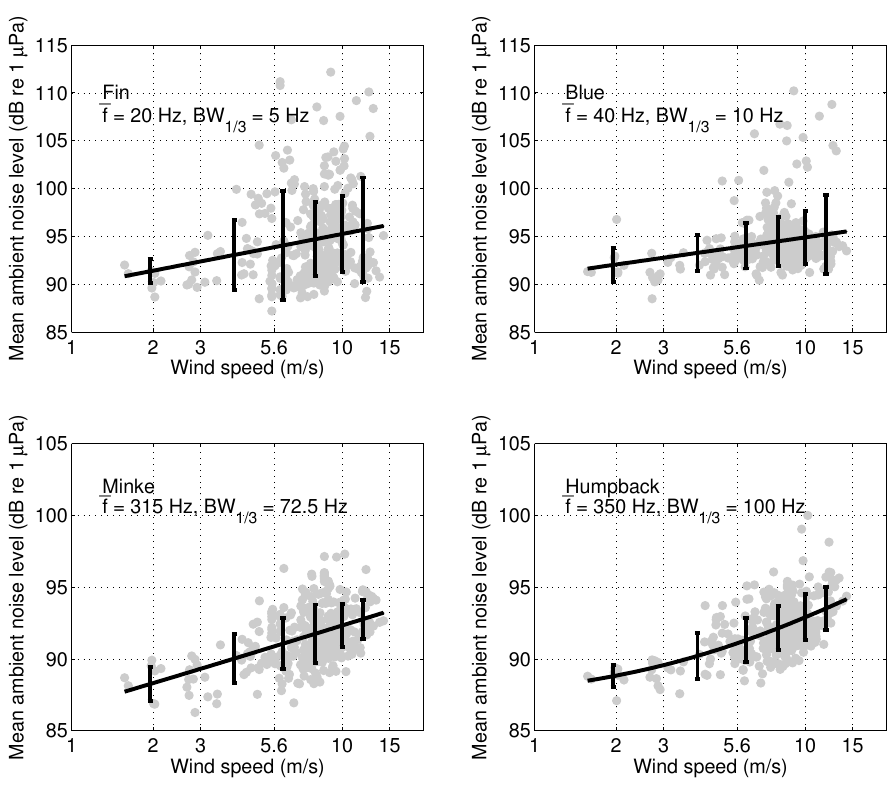
Figure A1. Wind dependence of Gulf of Maine mean ambient noise levels for frequency bands of baleen whale vocalizations given in Table 1. Gray filled circles represent the mean ambient noise levels determined from measurements obtained during the OAWRS 2006 experiment [1,2,22] using Equation (9) for frequency bands of baleen whale vocalizations given in Table 1. Black solid lines represent the empirical best fit of the measured ambient noise levels to the model given in Equation (11). Empirically determined coefficients of the model are given in Table 1. Black vertical lines represent the variation of the measured mean ambient noise levels for given wind speed. Instantaneous measurements of ambient noise fluctuate around each mean ambient noise level with 5.6 dB standard deviation